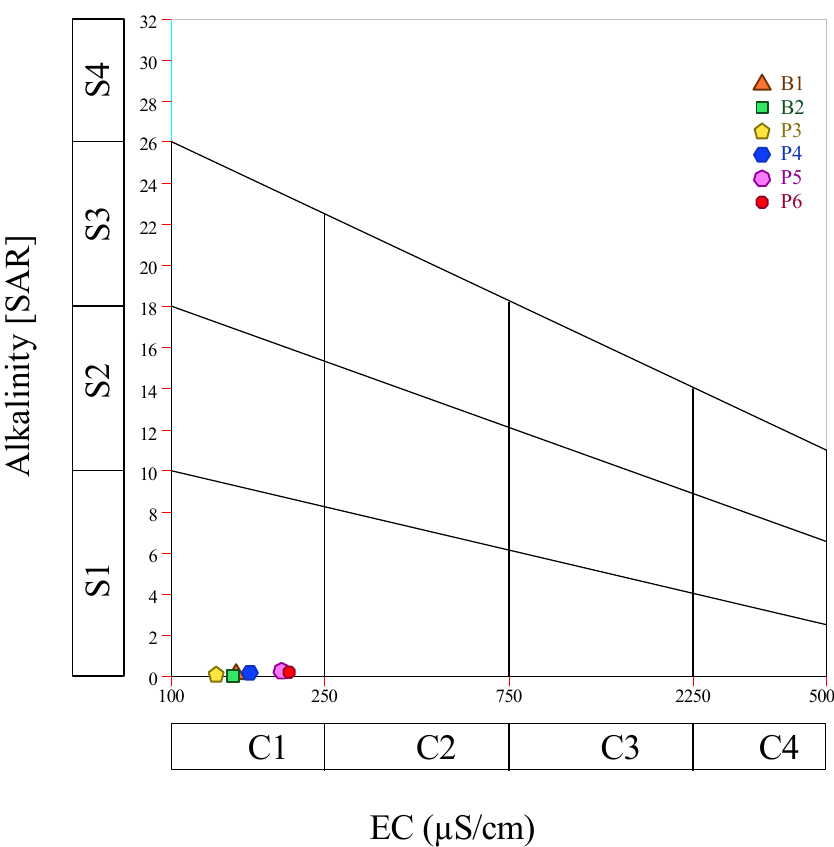
Figure 10. Wilcox diagram for irrigation water quality assessment.